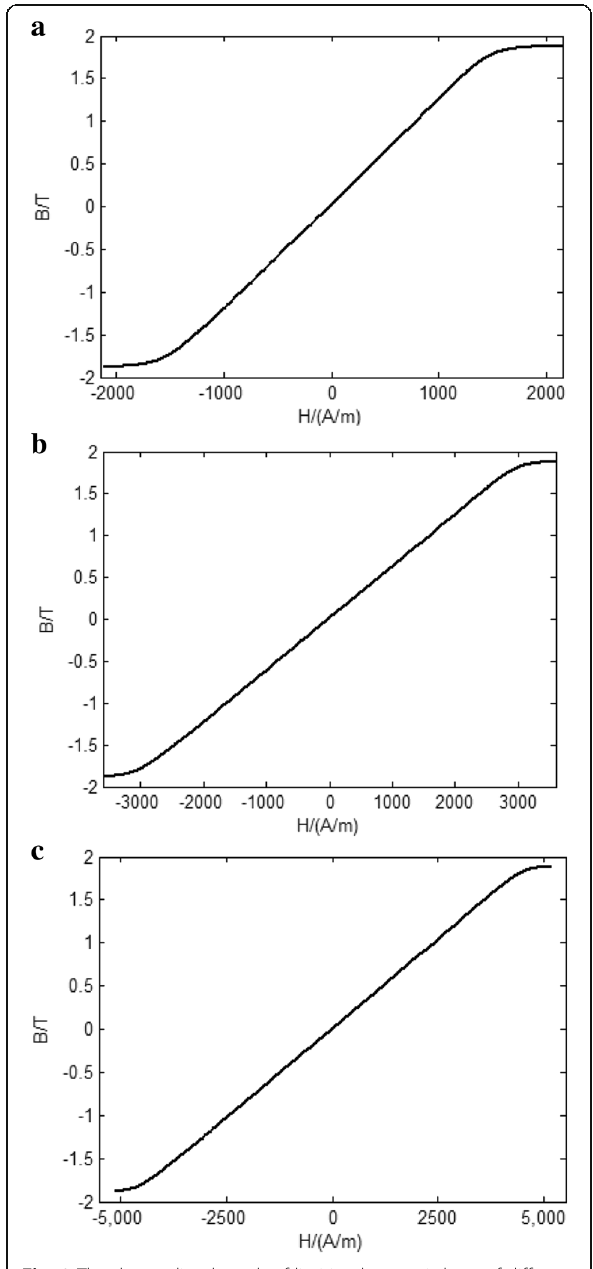
Fig. 9 The descending branch of limiting hysteresis loop of different air gap length ratios, a 0.001, b 0.002, c